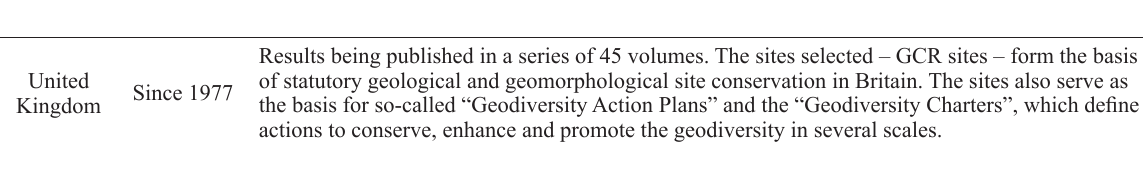
Practical developments related to the use of geosites’ data obtained from geoheritage national inventories. Country Period Developments from the